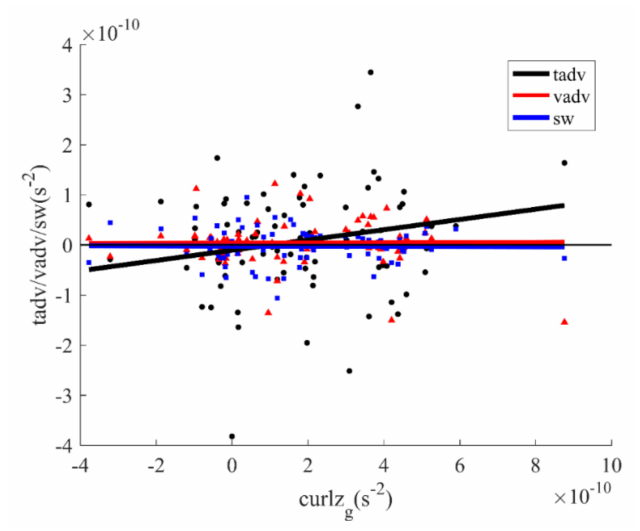
Figure 14. As in Figure 11, but based on the cyclones in the Northwest